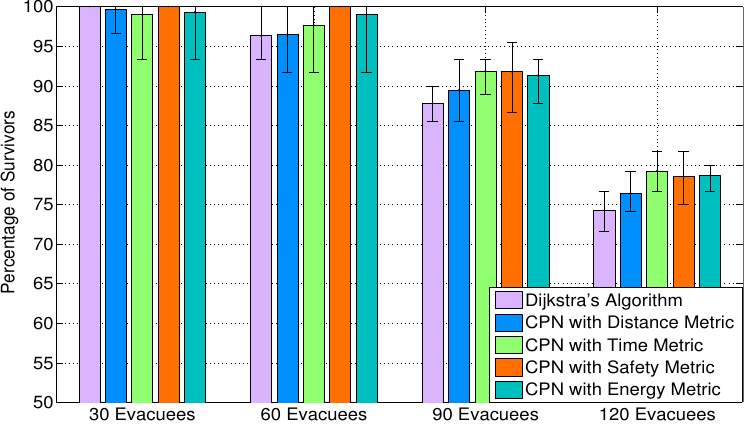
Figure 4. The percentage of survivors for diverse path-finding algorithms in scenarios with homogeneous evacuees. The results are the average of 10 randomized simulation runs, and the error bars show the min/max result in any of the 10 simulations.